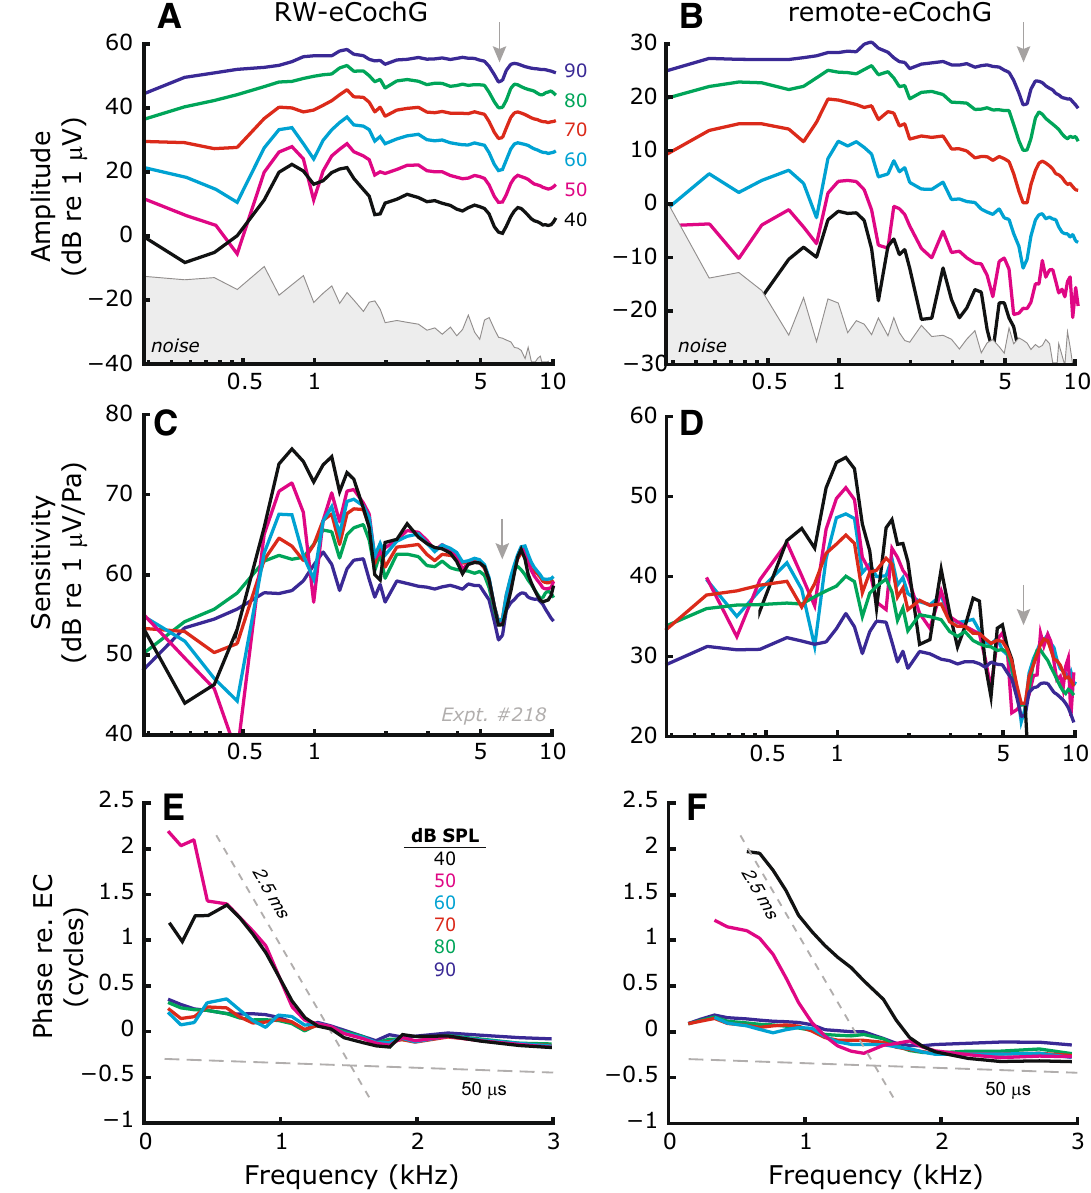
Figure 1. RW-eCochG and remote-eCochG in normal ears. Amplitude, sensitivity, and phase responses of eCochG measured with an electrode at the round window ( A , C , E ) and at the vertex of the skull ( B , D , F ), respectively. Sound pressure levels (SPL) were between 40 and 90 dB SPL in 10 dB steps. Sensitivity curves (amplitude normalized to ear canal pressure) would overlie each other if amplitude increased linearly with SPL. Dashed lines in panels ( E , F ) indicate group delays of 2.5 and 0.05 ms, respectively. Data from Expt. #218. The notch around 6 kHz ( gray arrows ) results from particulars in gerbil middle ear